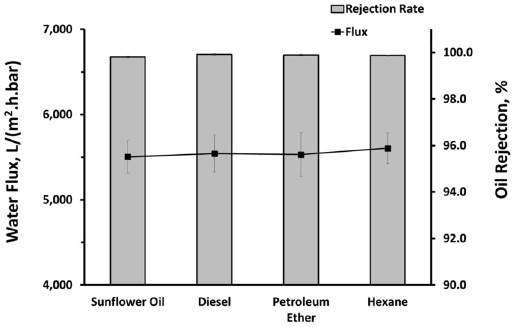
Figure 4. Permeate water flux and oil rejection ratio of different emulsified oil feeds filtrated using MWCNT- MnO